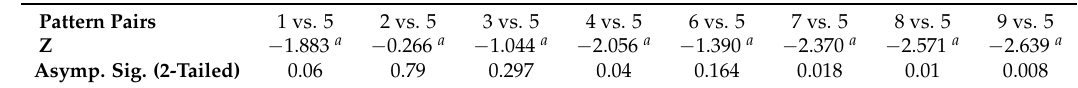
Table 3. Wilcoxon signed ranks test.